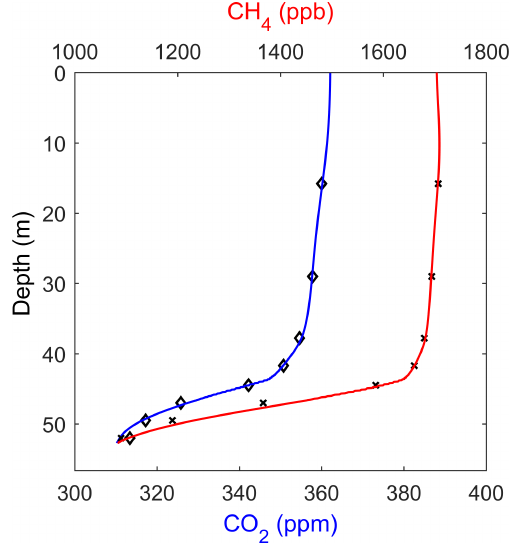
Figure 9. Simulated CO 2 and CH 4 concentrations in the firn at Law Dome DSSW20K. The model is forced with histories of at- mospheric CO 2 and CH 4 concentrations from 1800 to 1998CE (the date of sampling). Markers indicate observed CO 2 (diamonds) and CH 4 (crosses) concentrations (Trudinger et al., 2002).